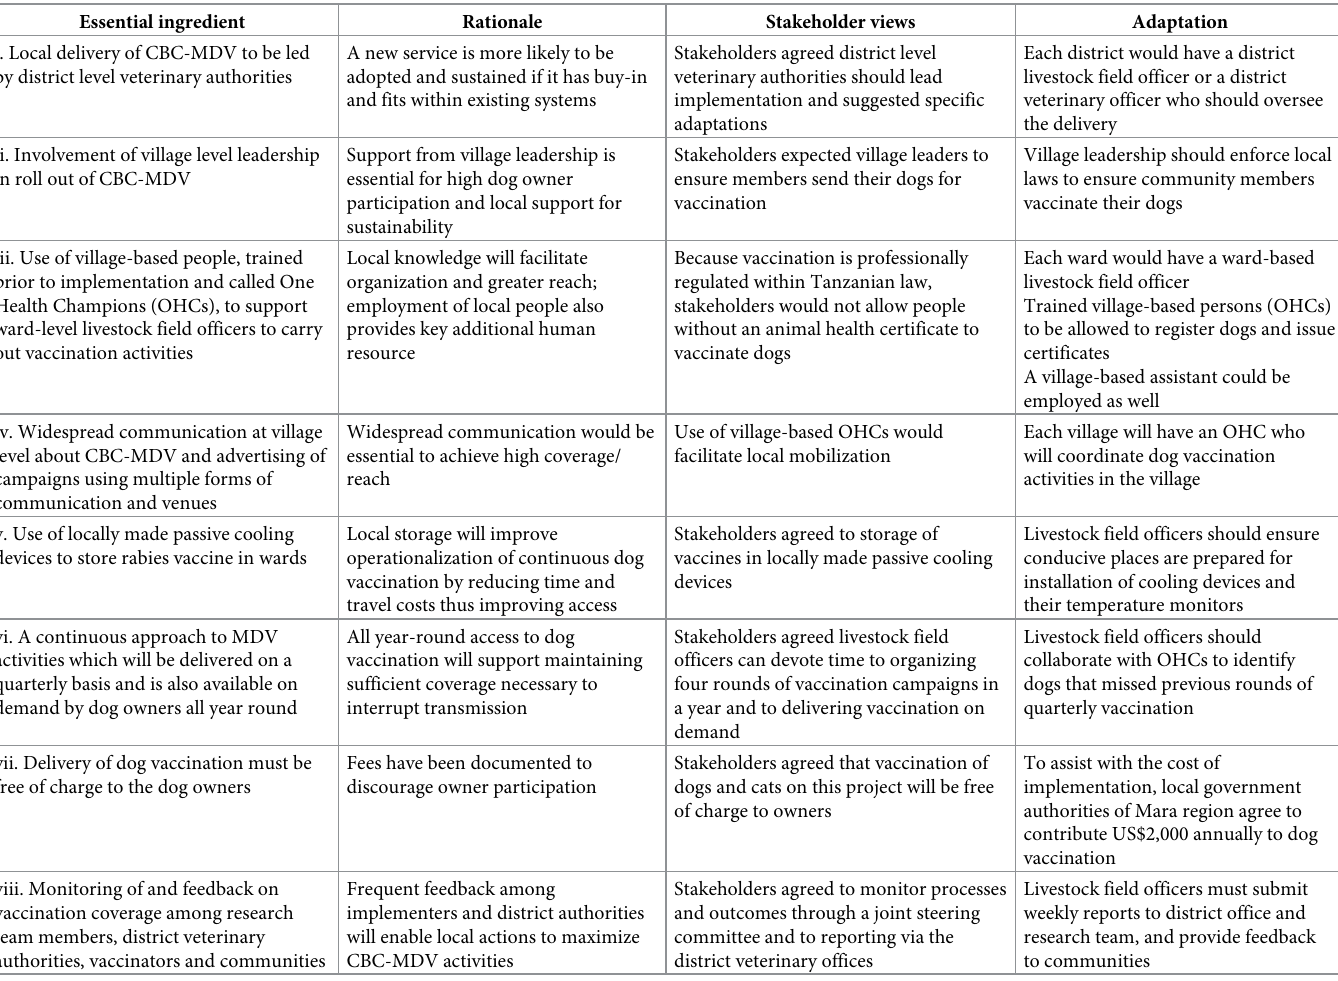
Table 3. Essential components of CBC-MDV and responses to stakeholder concerns.